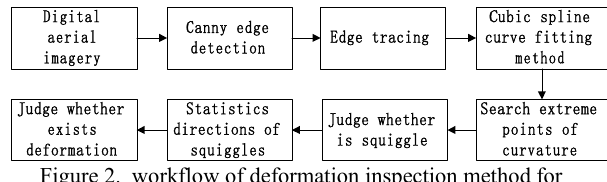
Figure 2. workflow of deformation inspection method for digital aerial imagery based on statistical characteristics 2.12.12.12.1 CCCContourontourontourontour extractionextractionextractionextraction andandandand pre-processingpre-processingpre-processingpre-processing ofofofof digitaldigitaldigitaldigital aerialaerialaerialaerial